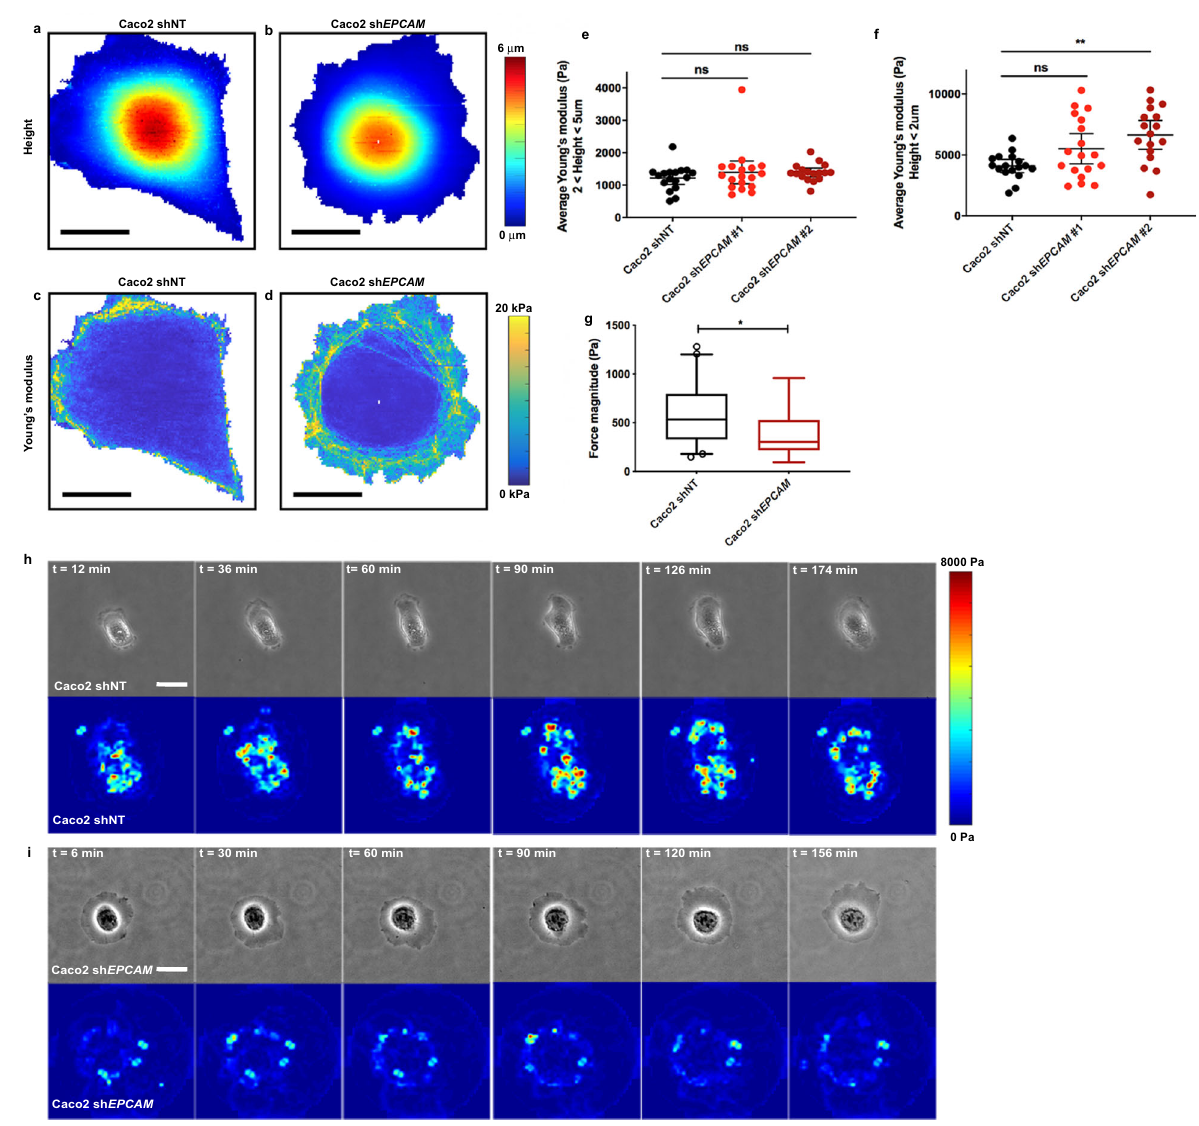
Fig. 3 Loss of EpCAM induces cell mechanical changes. a – d Maps showing the color-coded cell topography ( a , b ) and Physics LUT table color-coded local Young ’ s modulus ( c , d ) for a representative control (shNT) ( a , c ) and EPCAM -KD (sh EPCAM ) ( b , d ) cells. Color scale bar in a and b indicates the cell height ( μ m). Color scale bar in c and d indicates the force magnitude (kPa). Scale bar, 20 μ m. e , f Average Young ’ s modulus in the region of height in the range of 2 – 5 μ m ( b ) or in the region of height <2 μ m ( c ) for each cell. N (shNT) = 17 cells, N (sh EPCAM #1) = 18, and N (sh EPCAM #2) = 17. Each data point